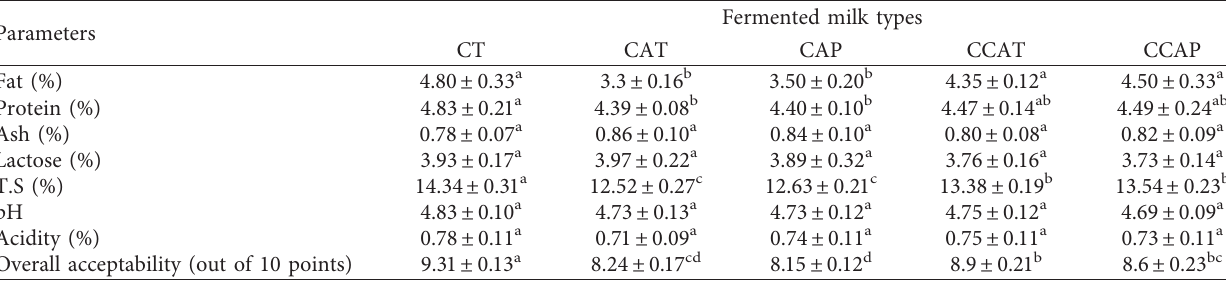
Table 3: Composition and sensory quality of different fermented milk products.